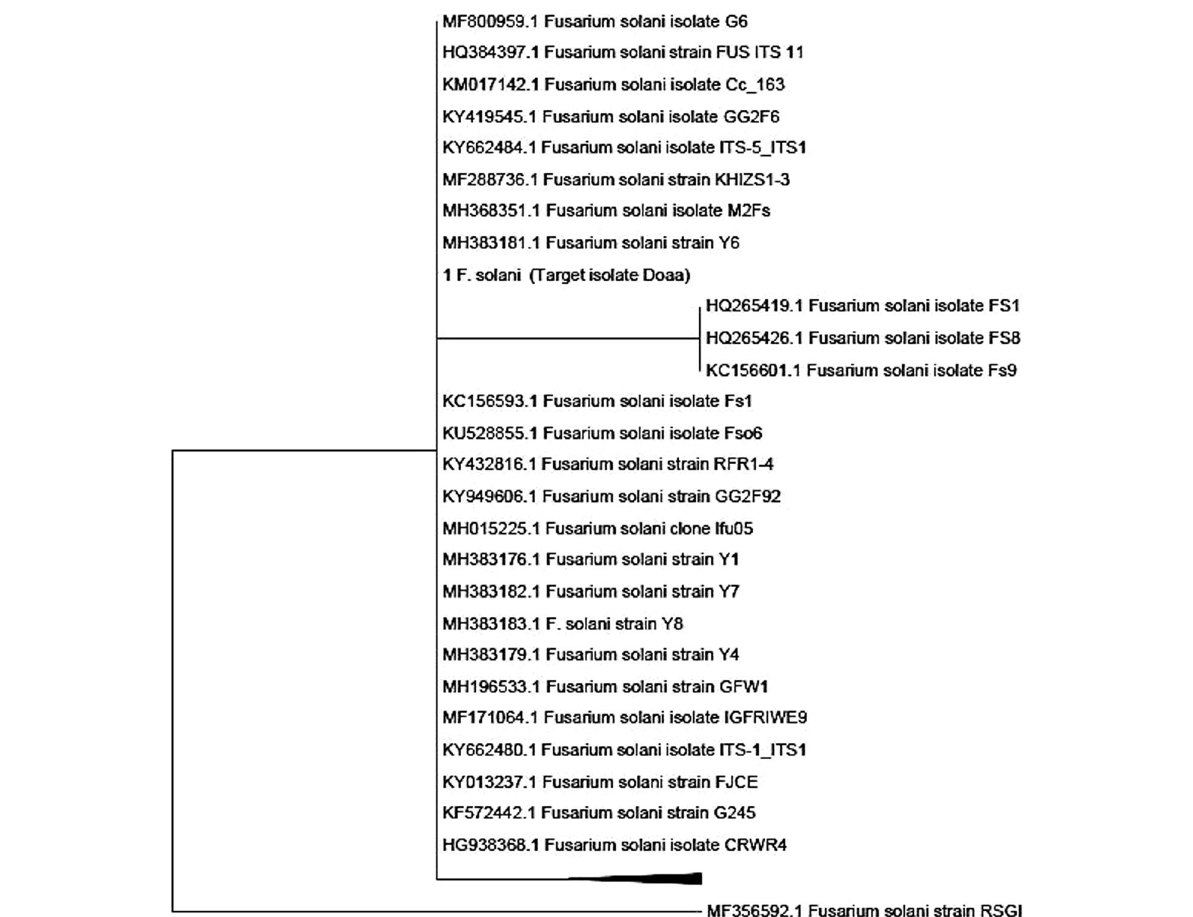
Fig. 3 A phylogenetic tree, generated using the neighbor-joining method showing the genetic relationship between the Iraqi F. solani isolate (indicated as Doaa) and other F. solani isolates available in GenBank